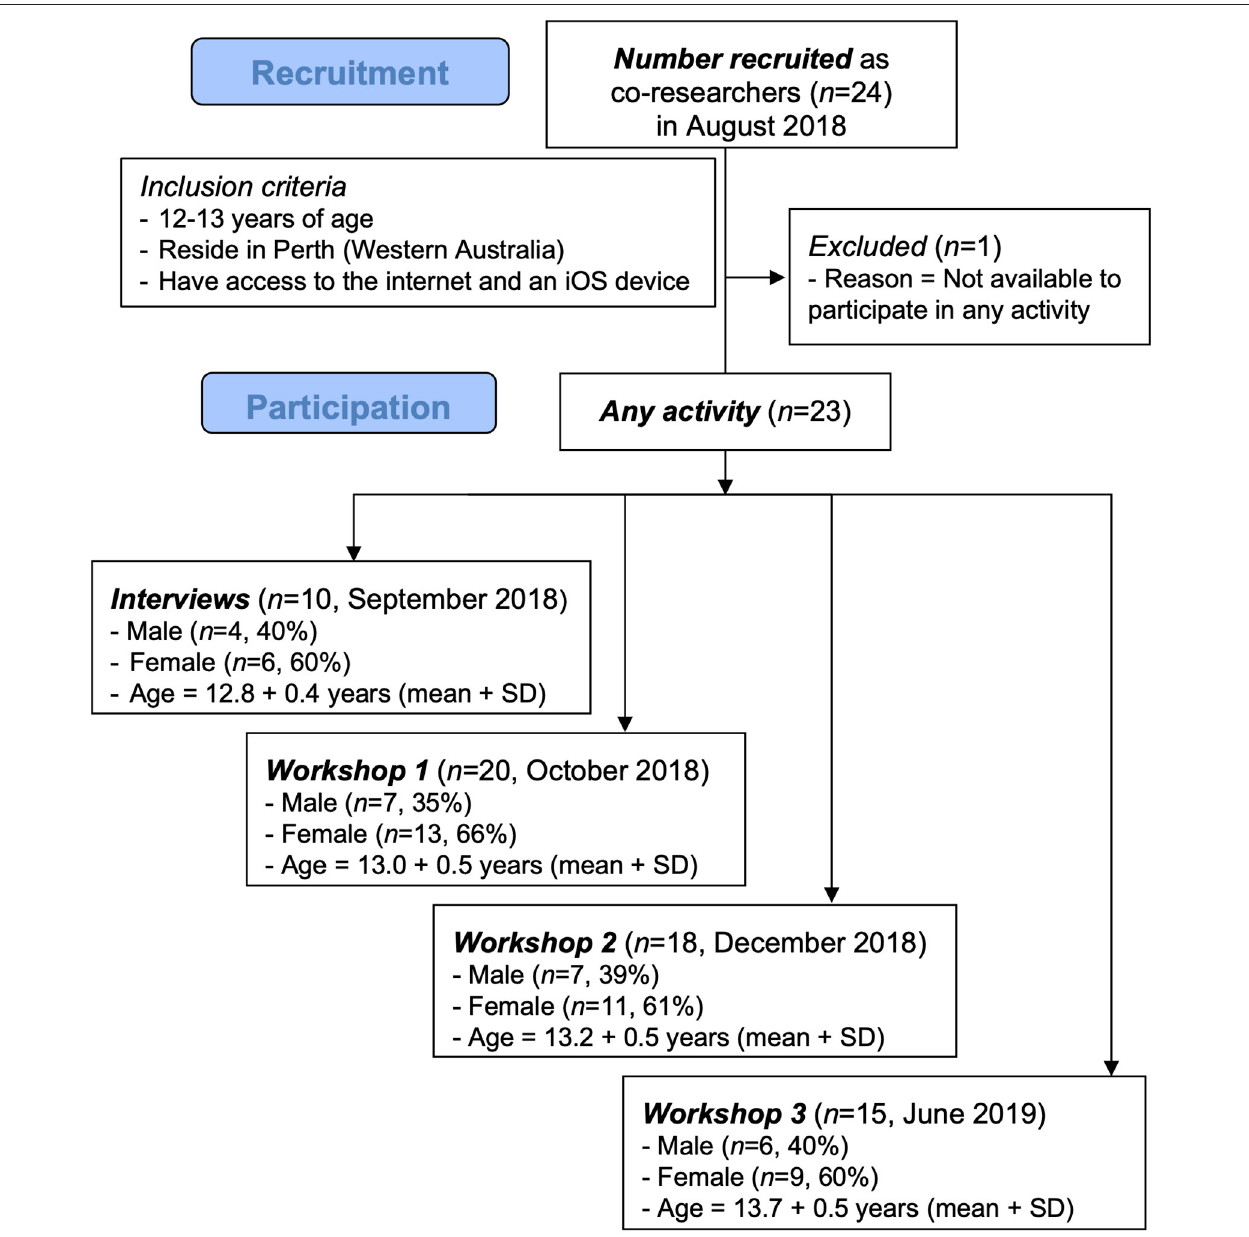
FIGURE 1 | Schema depicting co-researcher recruitment, including number, gender mix, and age for those participating in each